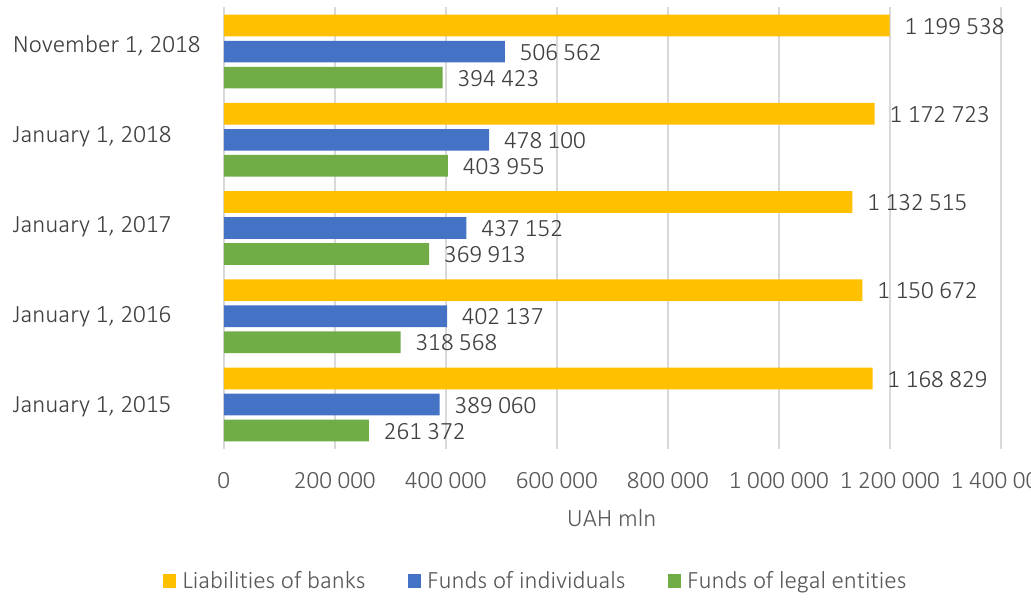
Figure 2. Amounts of liabilities and clients’ deposits in Ukrainian banks in 2015–2018